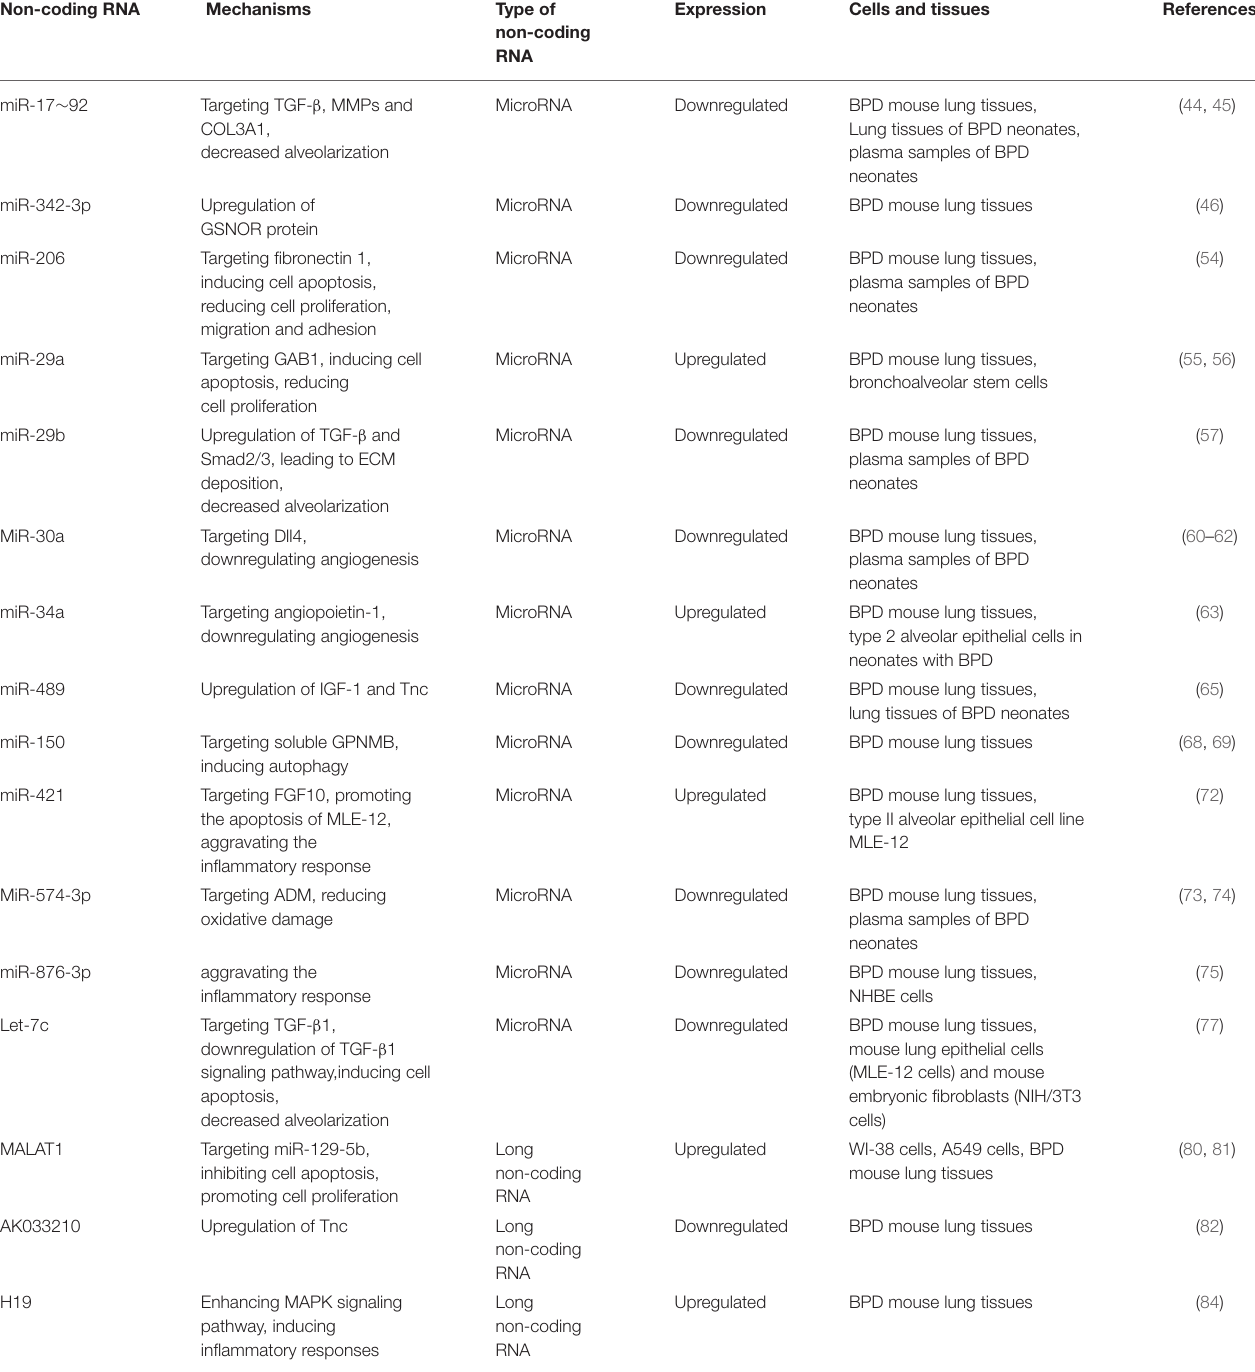
TABLE 1 | List of non-coding RNA currently implicated in bronchopulmonary dysplasia. Non-coding